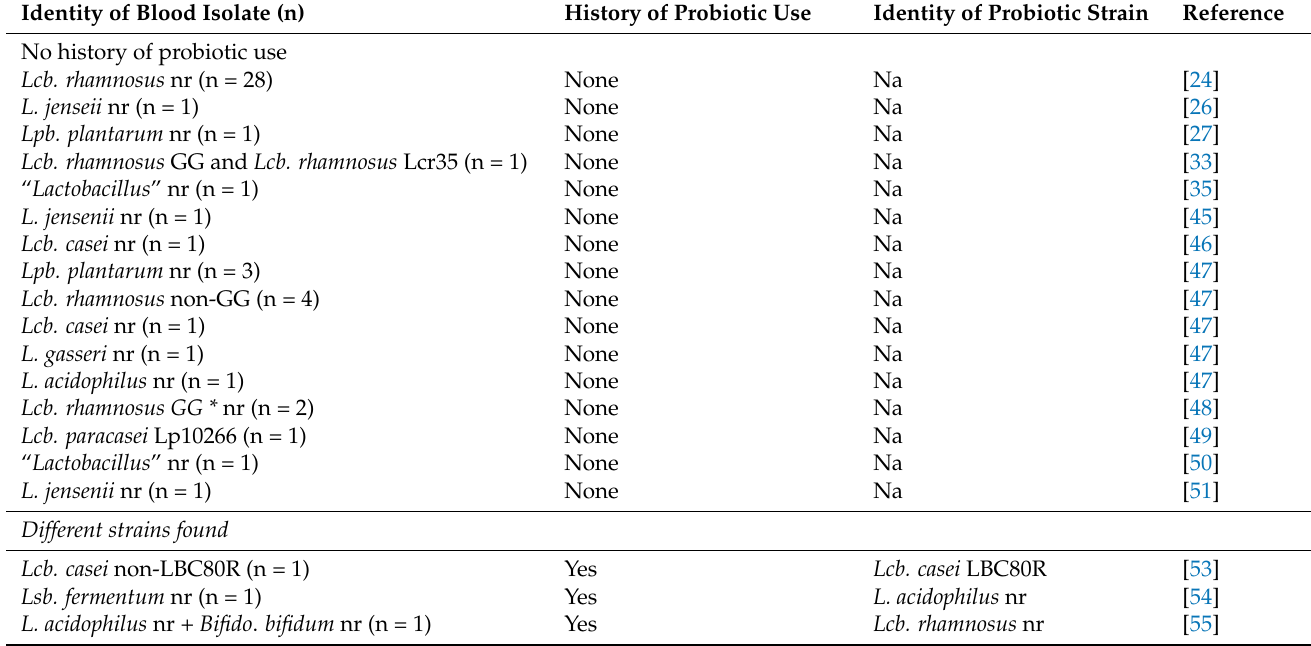
Table 2. Reports of possible Lactobacillus spp. bacteremia with no evidence of oral probiotic adminis- tration or cases where the blood isolate did not match the probiotic